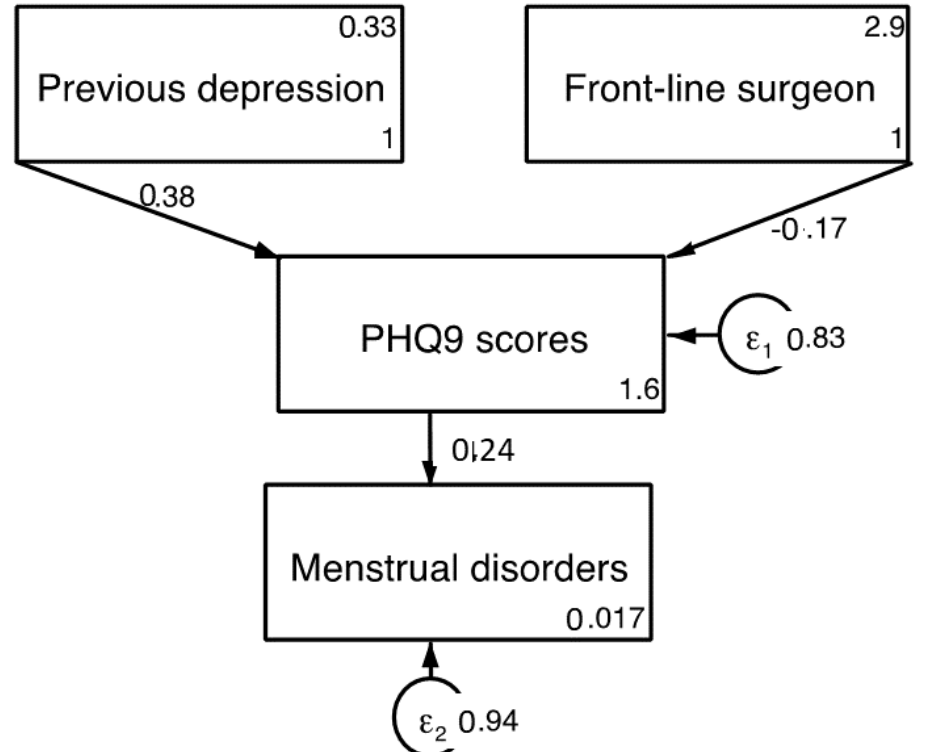
Figure 2. Predictive model for PHQ-9 scores. Chi sq (model vs. saturated) = 4.289; p < 0.117; Popu- lation error RMSEA = 0.073 ( p < 0.05); Akaike’s information criterion = 2528; Bayesian information criterion = 2552.213; Comparative fit index = 0.957; Tucker–Lewis index = 0.892; Standardized root mean squared residual = 0.036; Coefficient of determination =